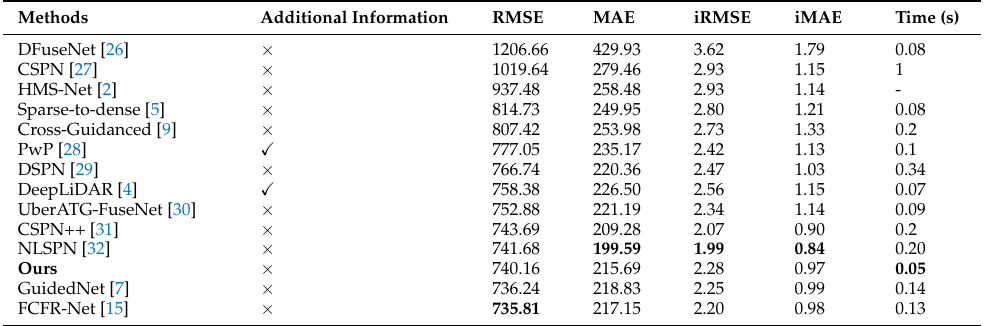
Table 1. Performance comparison using the KITTI testing dataset. We tested our method using the Net1 architecture. The results were evaluated by the KITTI testing server and the different methods were ranked according to their RMSE. “Additional information” means that the algorithm was trained with additional data or labels. Note that most of the runtimes in the table are from their own papers and were tested on different GPUs, so only rough comparisons could be drawn.